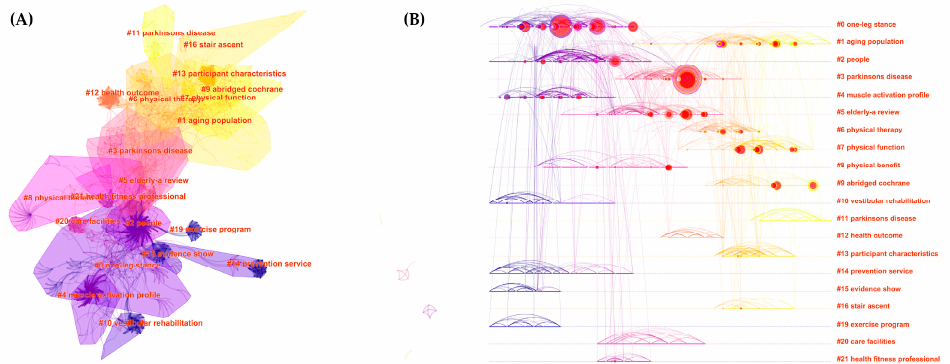
Figure 10. Visualized map of the co-cited reference clusters and timeline. ( A ) Map of the co-cited references clusters; ( B ) timeline view of co-cited references clusters.